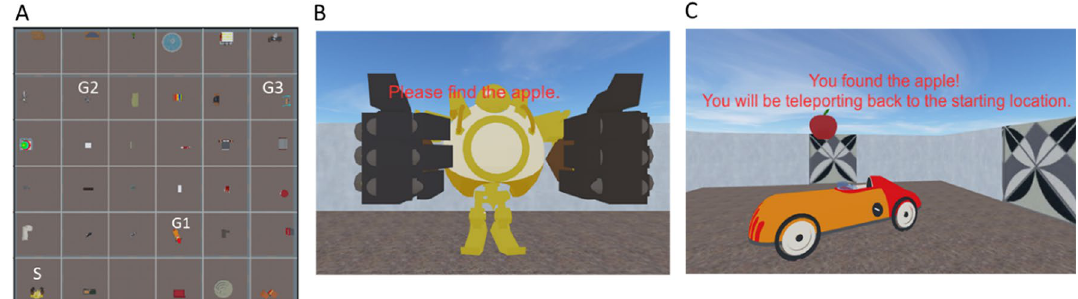
Figure 1. Experimental materials. ( A ) Layout of the environment. S indicates the fixed starting location in the Fixed phase, G1 ~ 3 indicate the goal object locations. ( B , C ) Actual view of landmark objects and rooms from the participants. Note that participants were brought back to the same starting location after finding a goal object during the Fixed